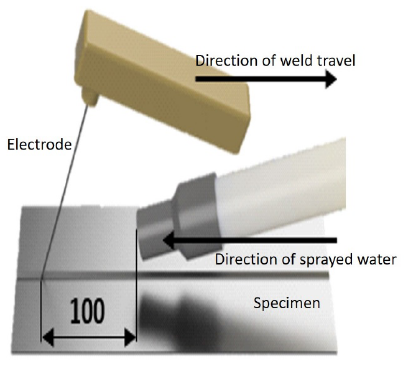
Figure 1: Dimension of test coupon (mm).